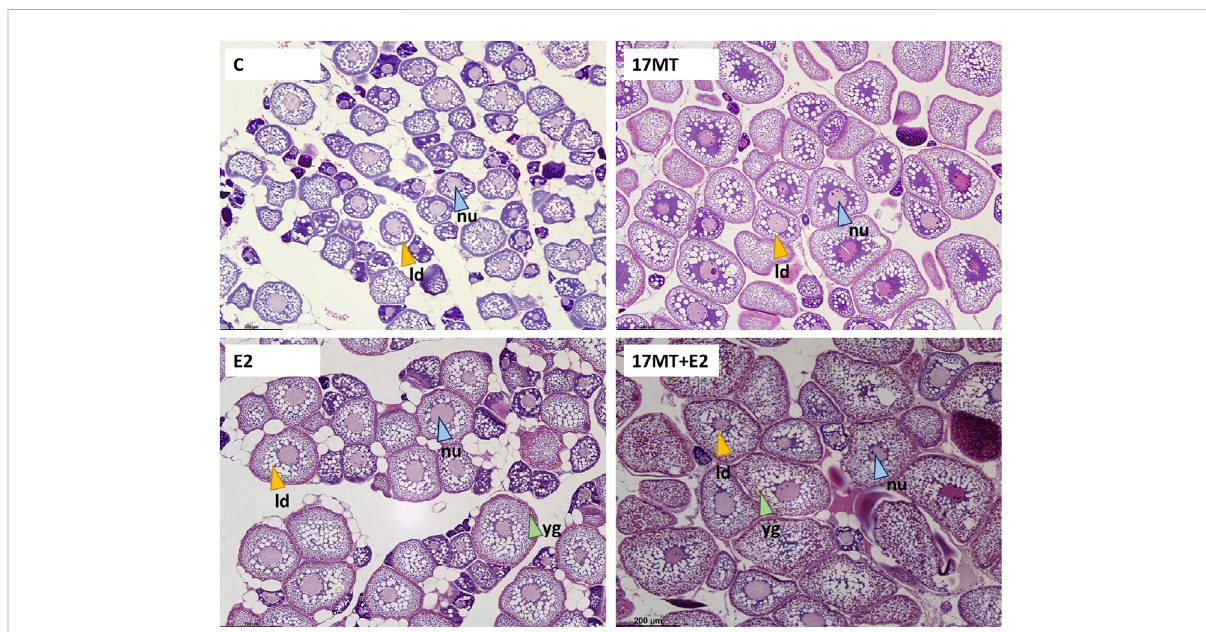
FIGURE 5 Oocytesintheeelovariesafterreceivinga2-monthssteroid-implanttreatment,with:control(Cgroup; N =10);17 α -methyltestosterone(17 MT group; N = 10); 17 β -estradiol (E2 group; N = 10), and co-implanted 17 MT and E2 (17 MT + E2 group; N = 10). Scale = 200 µm. Stain: Mayer ’ s haematoxylin and eosin. The white globules indicate the (empty) lipid droplets (ld — yellow arrows), bright pink globules are yolk globules (yg — green arrows). Acentralnucleus(nu — bluearrows)withperinucleolicanbeobserved. Forovariesofeelsofallgroups,smalldeveloping oocytes inthe perinucleolus stage and early lipid droplet stage could still be